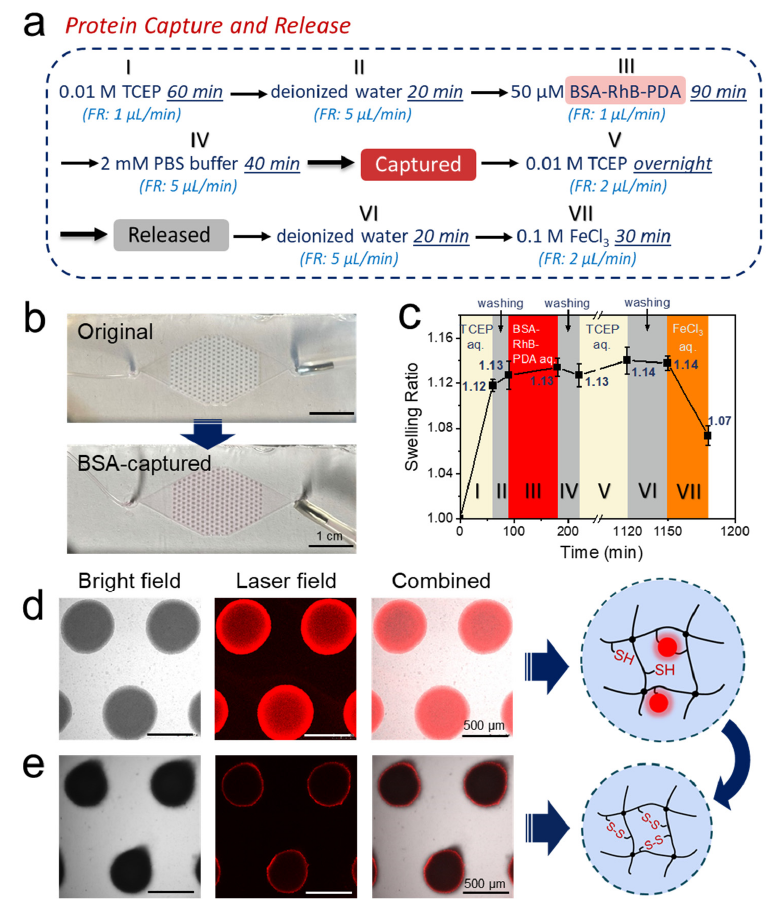
Figure 5. ( a ) Description of one measurement cycle to capture and release BSA-RhB-PDA, ( b ) Optical images of the original and BSA-captured hydrogel dot array in the microfluidic chip. ( c ) Swelling behavior of PNiPAAm hydrogel dots in one complete measurement cycle ( d ) Micrographs of the PNiPAAm hydrogel dots after BSA-RhB-PDA has been captured, ( e ) Micrographs of the PNiPAAm hydrogel dots after completing one whole cycle (i.e., after releasing the previously captured BSA-RhB-PDA of ( b )). Both cartoons ( d , e ) refer to the composition of each hydrogel dots at the time of the measurements. All the hydrogel dots studies were performed in microfluidic chip at room temperature and observed by confocal laser fluorescence microscope under bright field, laser field and the fields combined at the height of 80 µm (channel height: 150 µm).